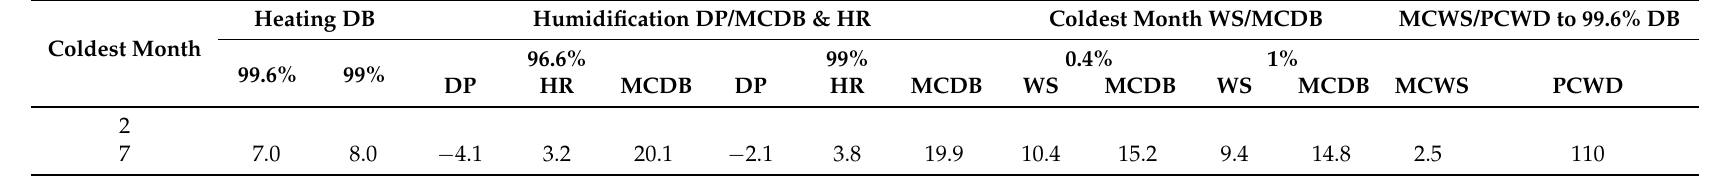
Table 4. Climatic design conditions (a) for Harare, Zimbabwe [44].